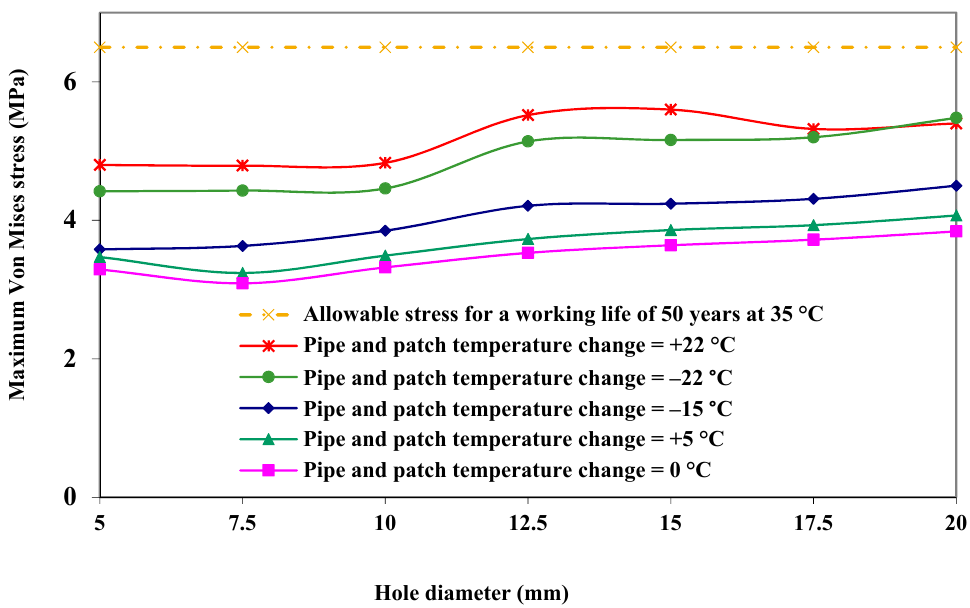
Figure 18. Maximum Von Mises stress in 3 inch long, saddle fusion patch for various sizes of circular hole defects (the simultaneous effect of mechanical and thermal loads).